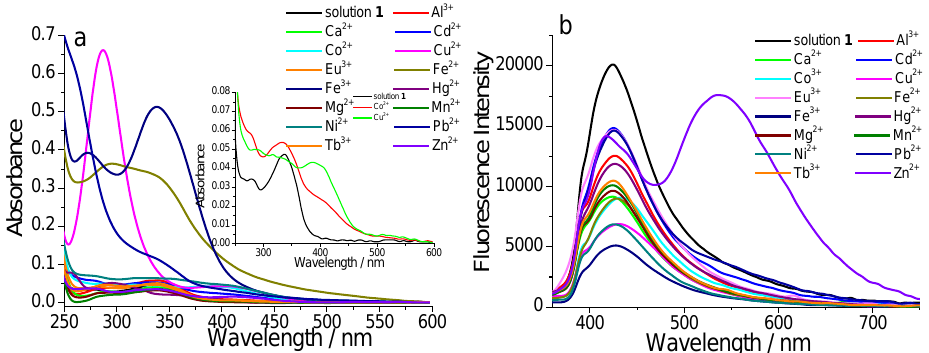
Figure 8. UV-vis absorption ( a ) and fluorescence spectra ( b ) changes of compound 1 in 1,4-dioxane (10 −5 M) solution adding 10 eq. of different metal ions.